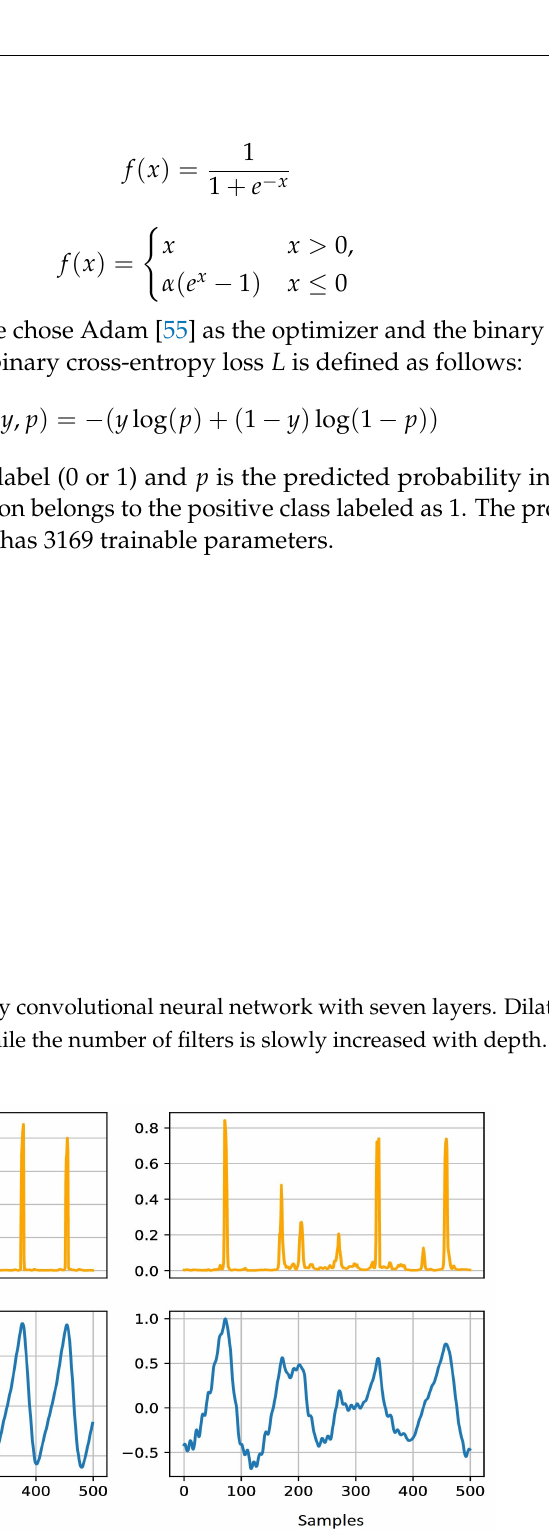
Figure 8. Two examples of inputs (i.e., PPG with different noise levels) and the model predictions. The lower row shows the two inputs, and the upper row includes the two labeling vectors predicted by the